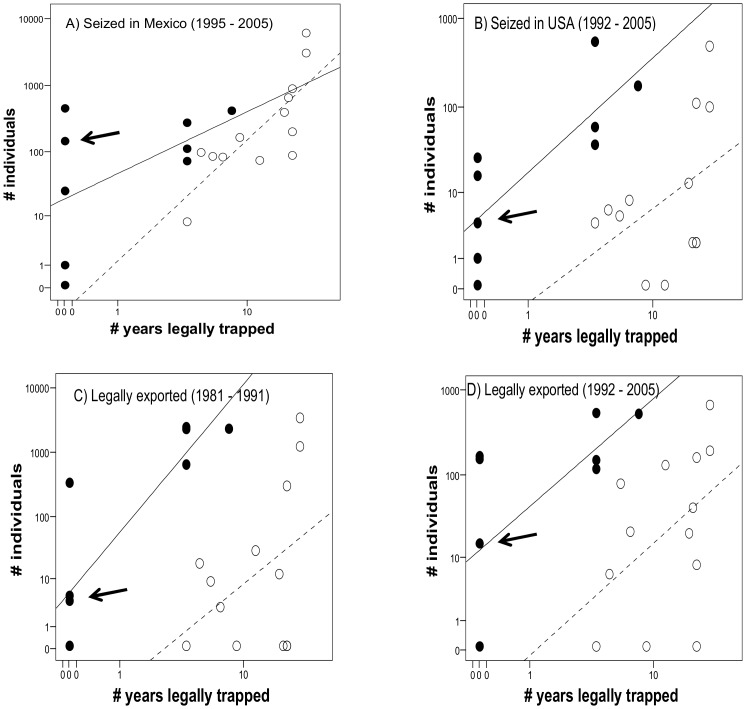
Number of Mexican parrots illegally (A and B) and legally (C and D) traded related to their current conservation status and the number of years the capture of each species was legally allowed in Mexico.Black dots represent threatened (Vulnerable and Endangered) species while empty dots represent non-threatened species according to IUCN (2013). Arrows indicate the scarlet macaw (Ara macao), a species that is not globally threatened but whose subspecies endemic to Central America is Endangered. Results excluding this species (not shown) are nearly identical. Data are log-transformed since they fit a Poisson-like distribution. Regression lines are fitted for each group of species.